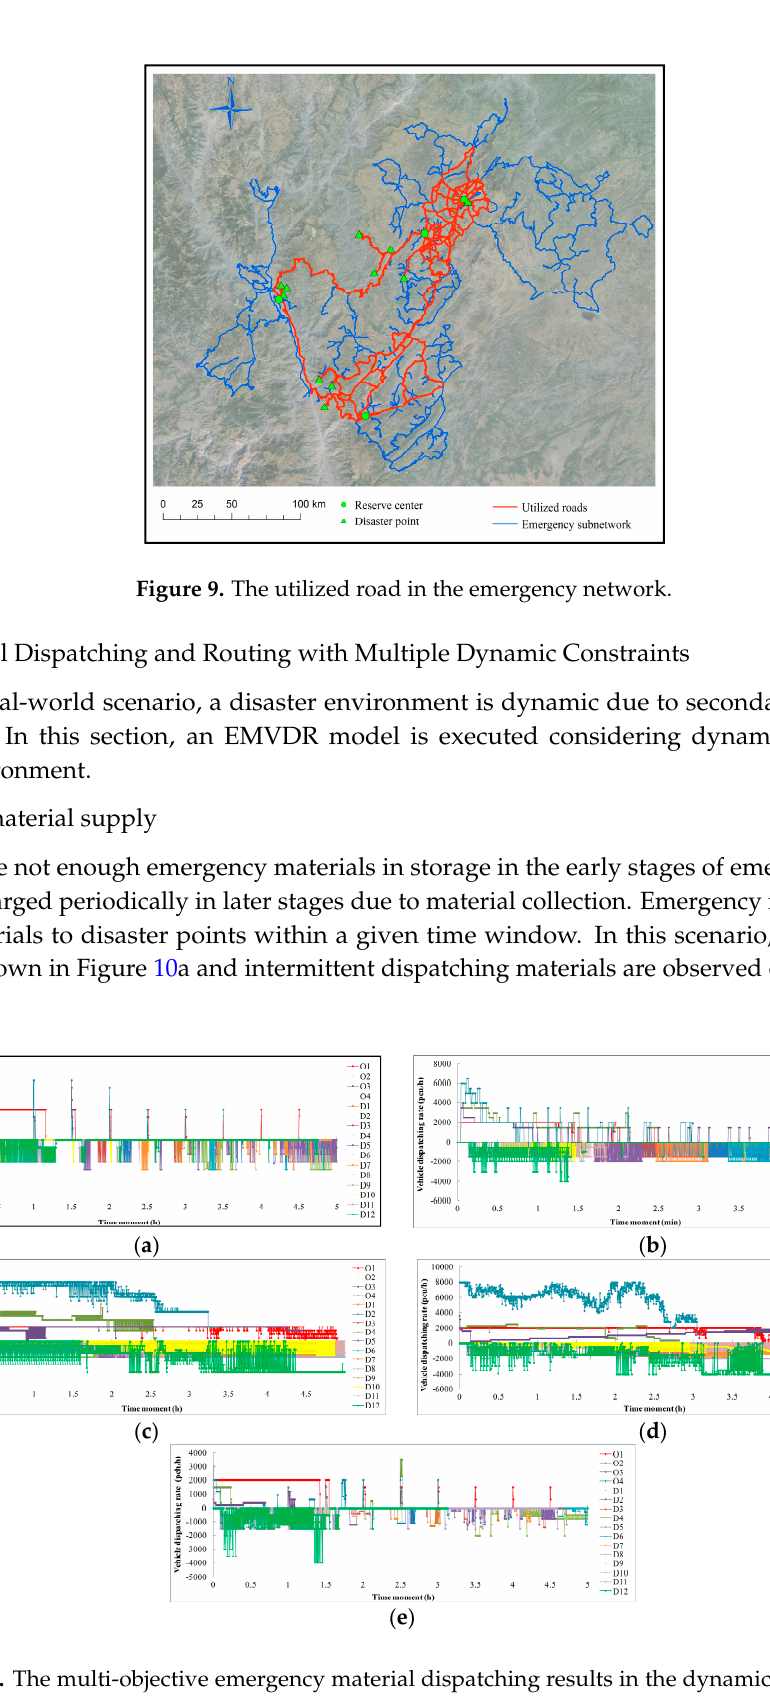
Figure 8. The emergency material dispatching result in the static situation: ( a ) single-objective; ( b ) multi-objective, where a positive value is the departure rate and a negative value is the arrival rate.